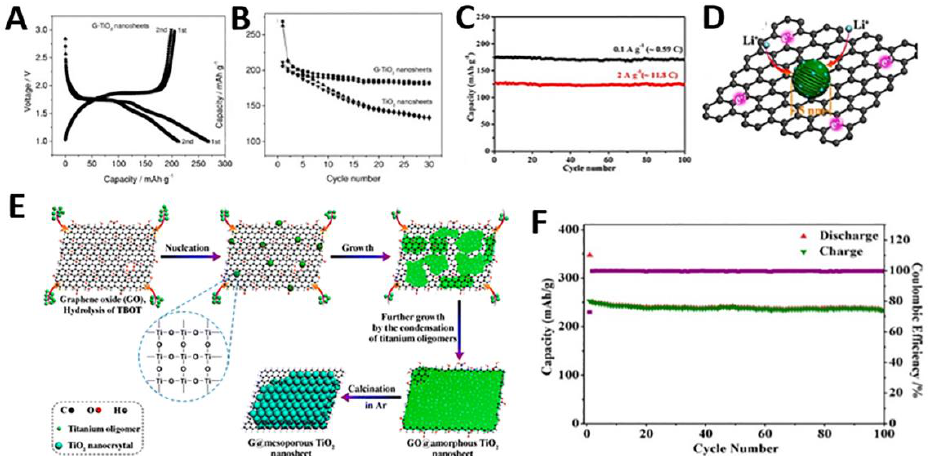
Figure 11. ( A ) First two charge-discharge curves of TiO 2 /G nanosheets at a current density of 0.2 C. ( B ) Cycling performance of TiO 2 /G and TiO 2 nanosheets at a current density of 0.2 C. ( A , B ) Reprinted with permission from Ref. [75], Copyright (2011) John Wiley and Sons. ( C ) Cycling performance of the TiO 2 /rGO sheet electrode at constant density of 0.1 and 0.2 A g − 1 . ( D ) Schematic representation of the electrochemical reaction path on the TiO 2 nanocrystals/rGO sheets. ( C , D ) Reprinted with permission from Ref. [96], Copyright (2013) American Chemical Society. ( E ) Schematic formation process of the mTiO 2 /G/mTiO 2 sandwich-like nanosheets. ( F ) Plots of specific capacity and CE of the mTiO 2 /G sandwich-like nanosheet electrode as a function of cycle number at a constant current density of 20 mA g −1 . ( E , F ) Reprinted with permission from Ref. [97], Copyright (2015) American Chemical Society.